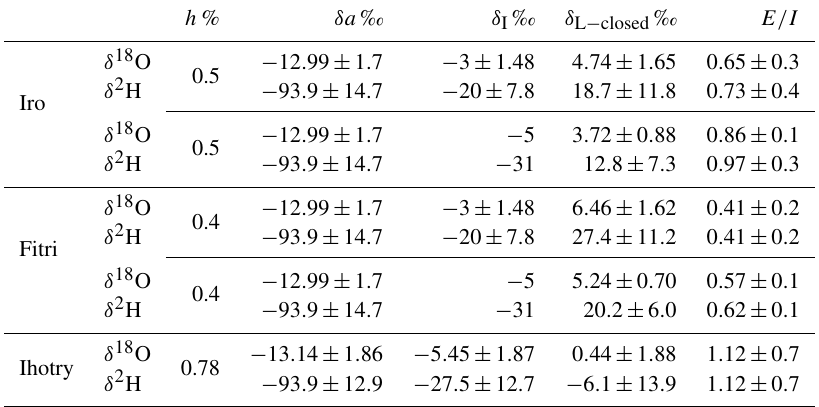
Table 1. Uncertainties in δ L − closed and E/I , for the three lakes studied, propagated from 1 σ standard deviations for δa and δI